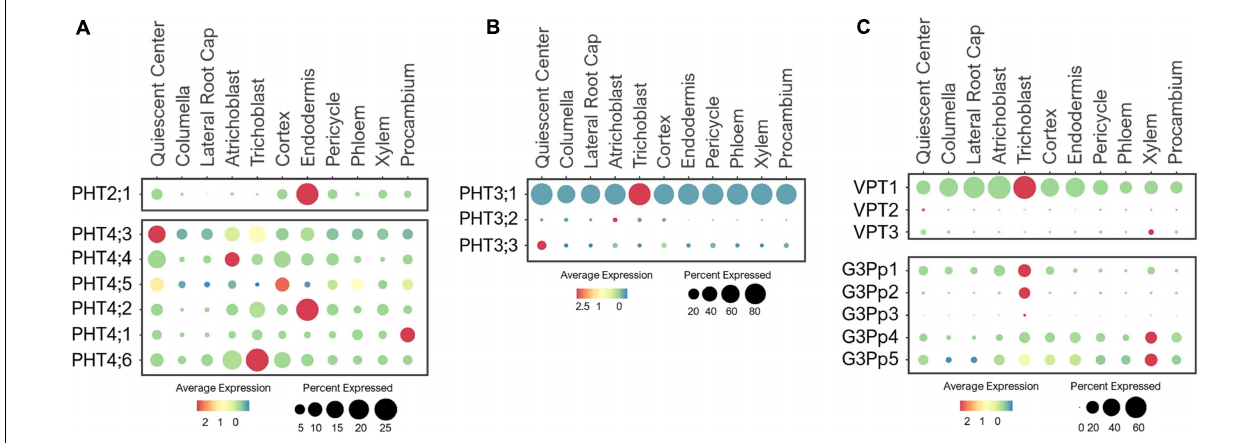
Frontiers in Plant Science |